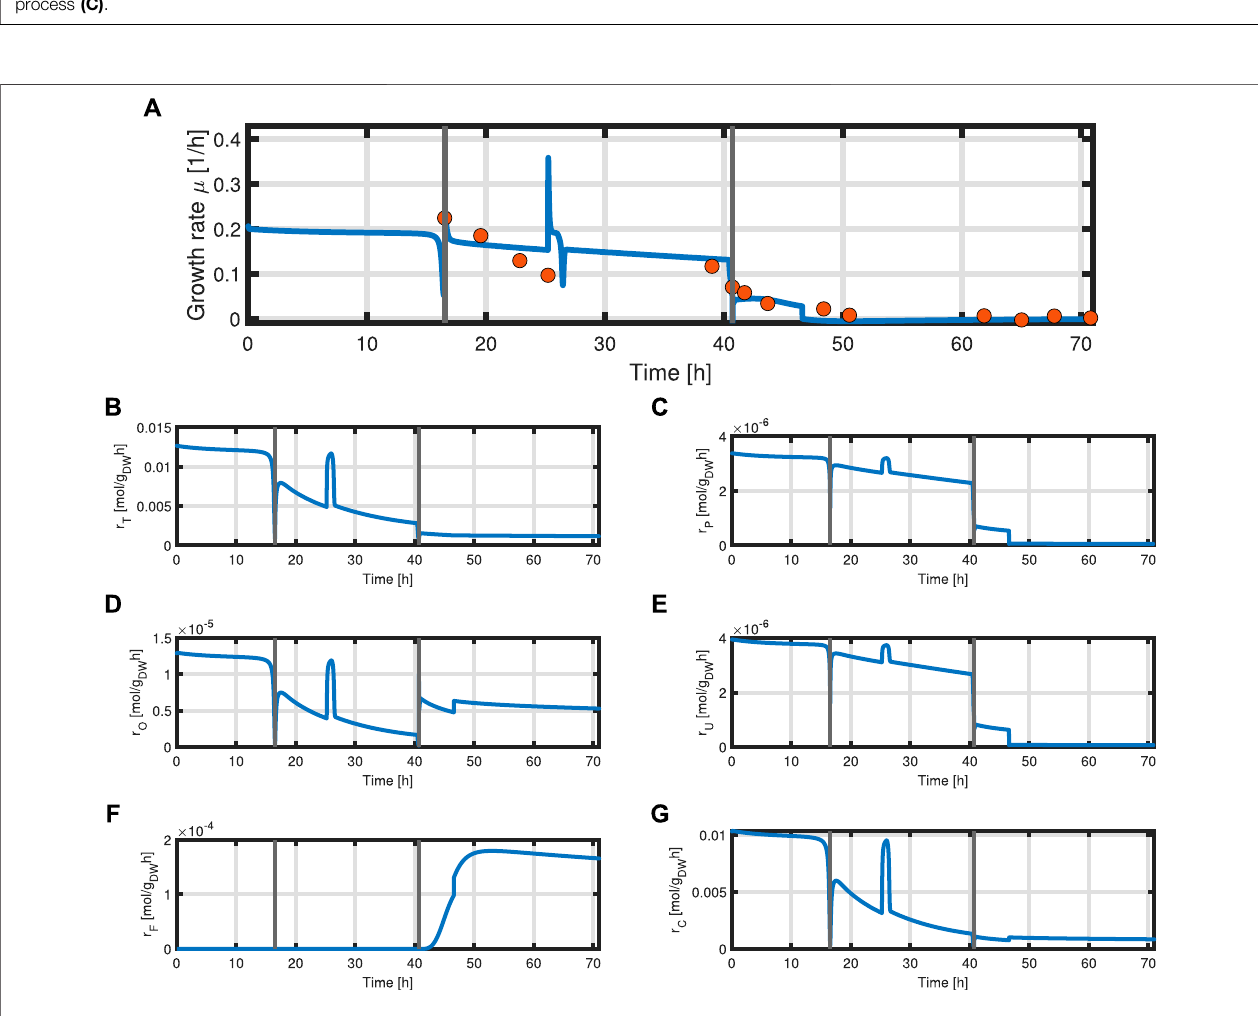
FIGURE9| Timecourseofthesimulatedspeci fi cgrowthrate μ (blue)andthepoint-wisecalculatedspeci fi cgrowthrateobtainedfromexperimental dataindicated asorangedots (A) ,substratetransportrate r T (B) ,proteinsynthesisrate r P (C) ,over fl owmetabolismrate r O (D) ,residualbiomasssynthesisrate r U (E) ,productformation rate r F (F), and respiration rate r C (G)